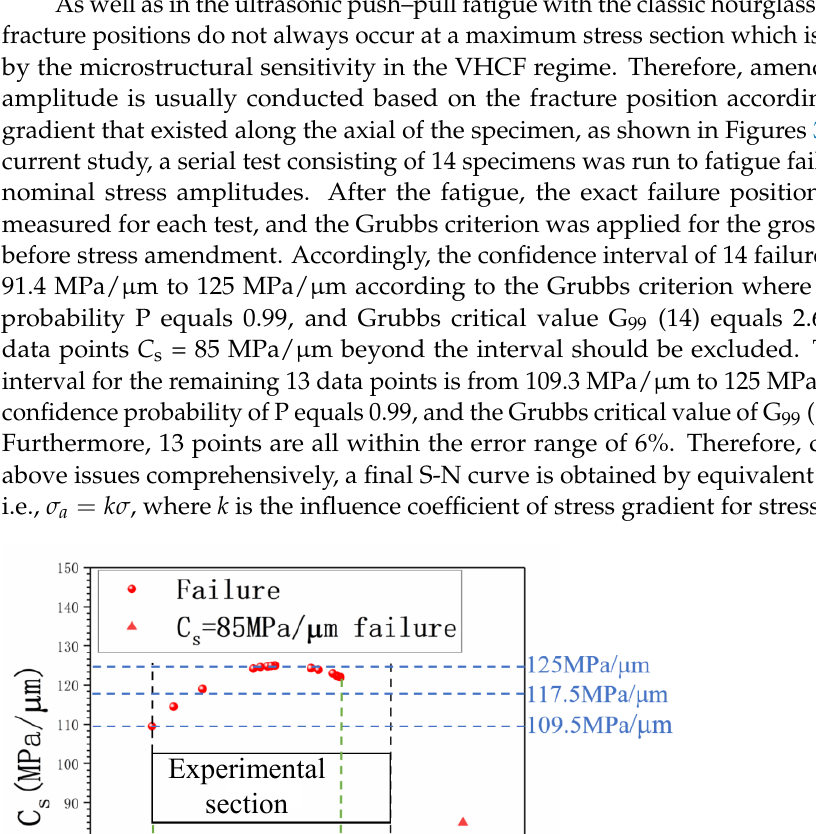
Figure 6. Thermal image of the specimen during resonance: ( a ) Without air-cooled; ( b ) air-cooled.